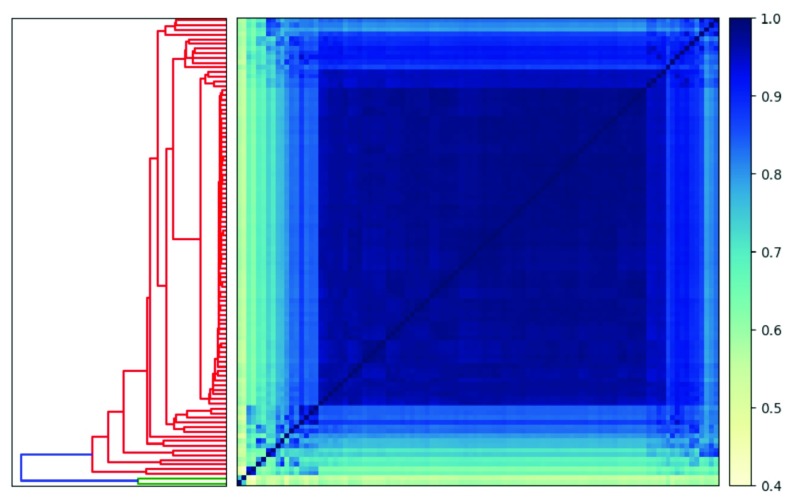
Heatmap and dendrogram generated using
sourmash signatures built from scaffolds in the domesticated olive genome.Two scaffolds are outliers when using tetranucleotide frequency to calculate similarity (highlighted in green on the dendrogram).